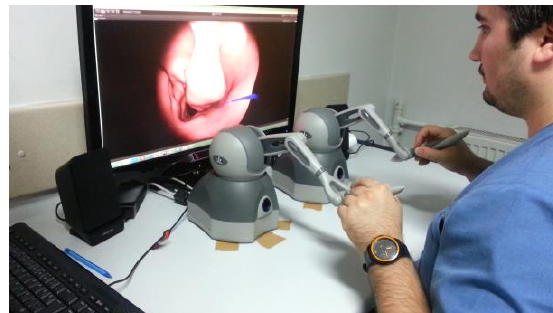
Figure 5. Experimental